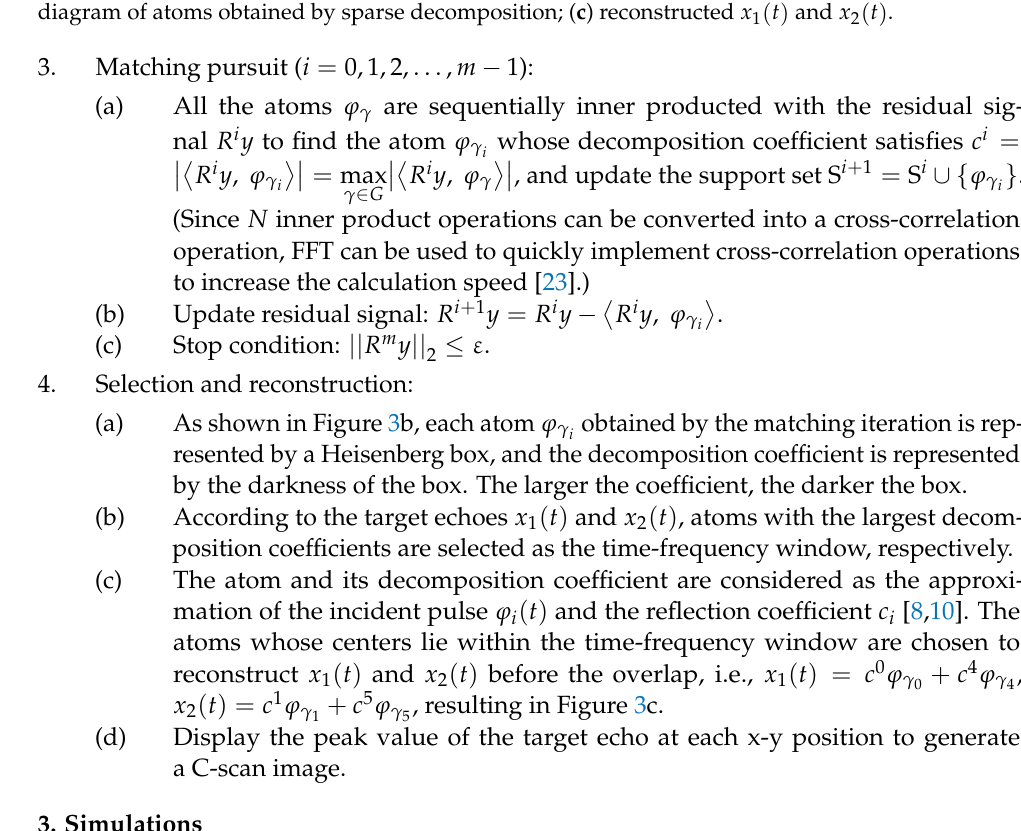
Figure 3. Sparse decomposition and echoes reconstruction: ( a ) AMI signal; ( b ) time-frequency diagram of atoms obtained by sparse decomposition; ( c ) reconstructed x 1 ( t ) and x 2 ( t )